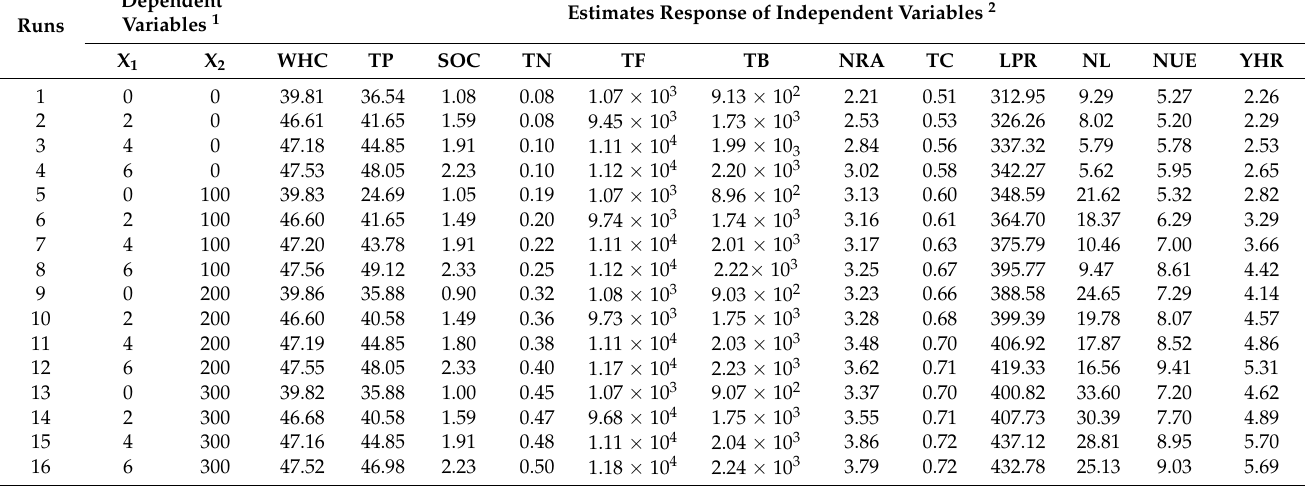
Table 6. Least square means (LS-Means) of independent variables under experimental